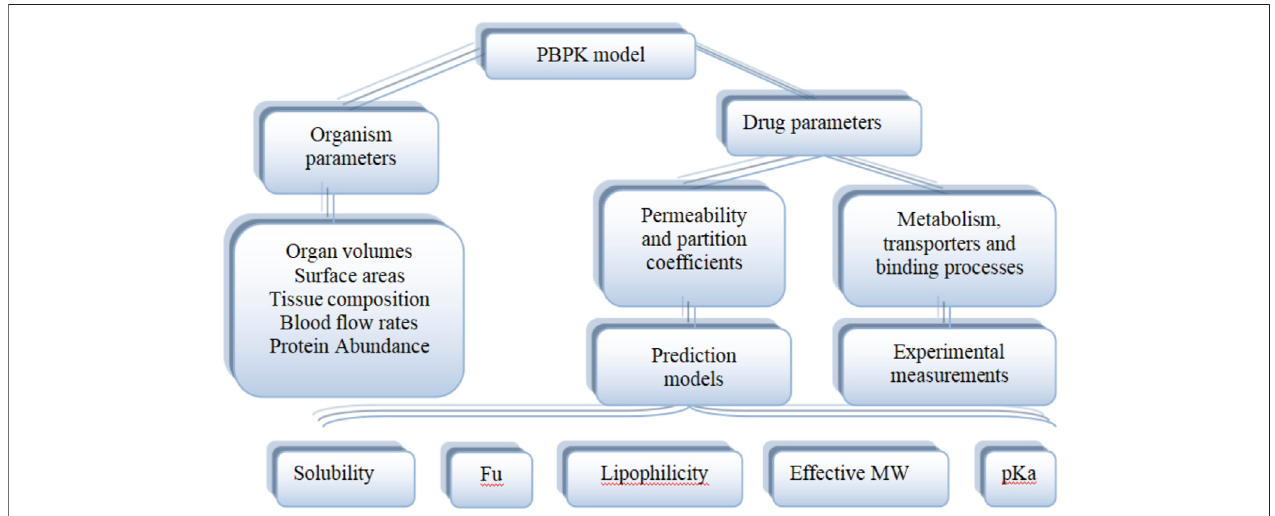
FIGURE 5 | Physiological and drug parameters in PBPK models (Adapted from Kuepfer et al., 2016).